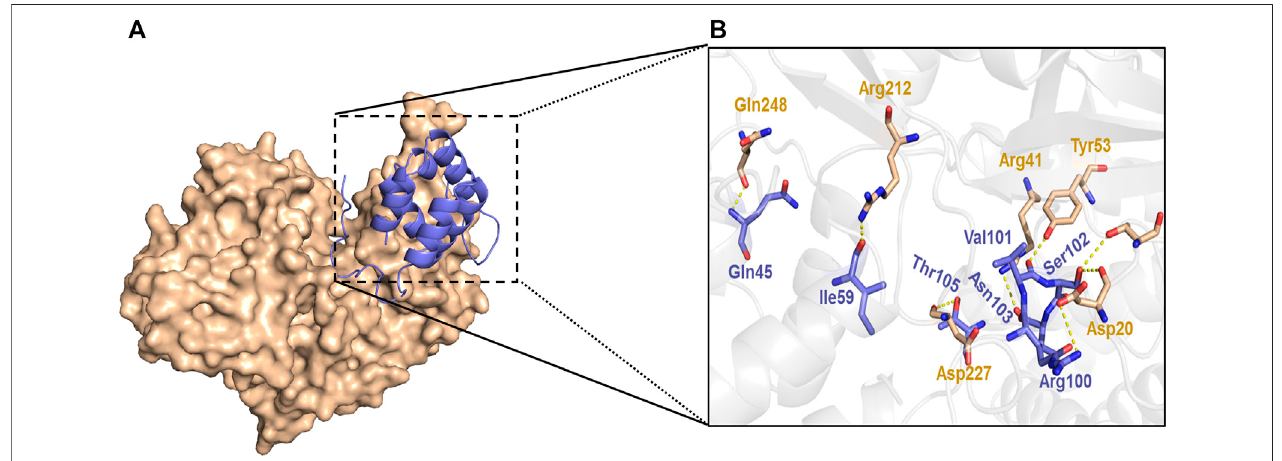
FIGURE8| Interaction betweenNLRP3 andGSDMD-N.InteractionbetweenNLRP3and GSDMD-N wasdisplayedusingZDOCK. Substrate-bindingsurface (A) . Interactions of NLRP3 with active amino acid sites and GSDMD-N (B) . The NLRP3 protein is shown in purple color solid ribbon, while GSDMD-N protein is in